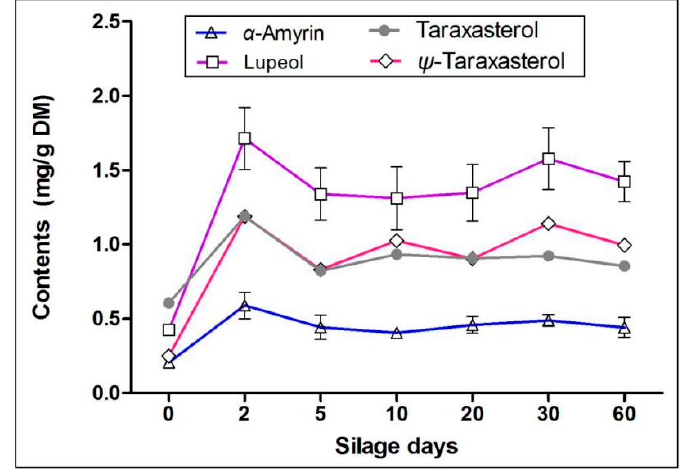
Figure 4. Effects of silage on pentacyclic terpenoids in artichoke by-products.